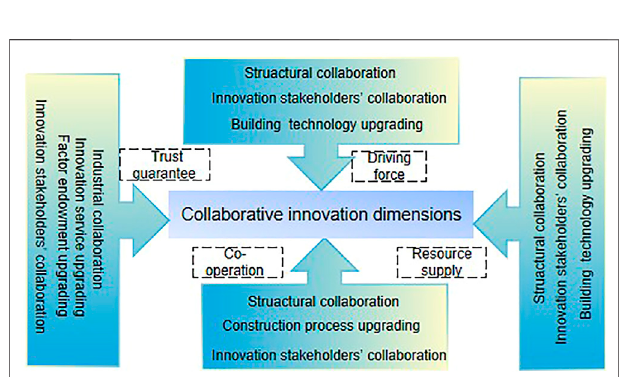
FIGURE 6 | Dimensions in the collaborative development of